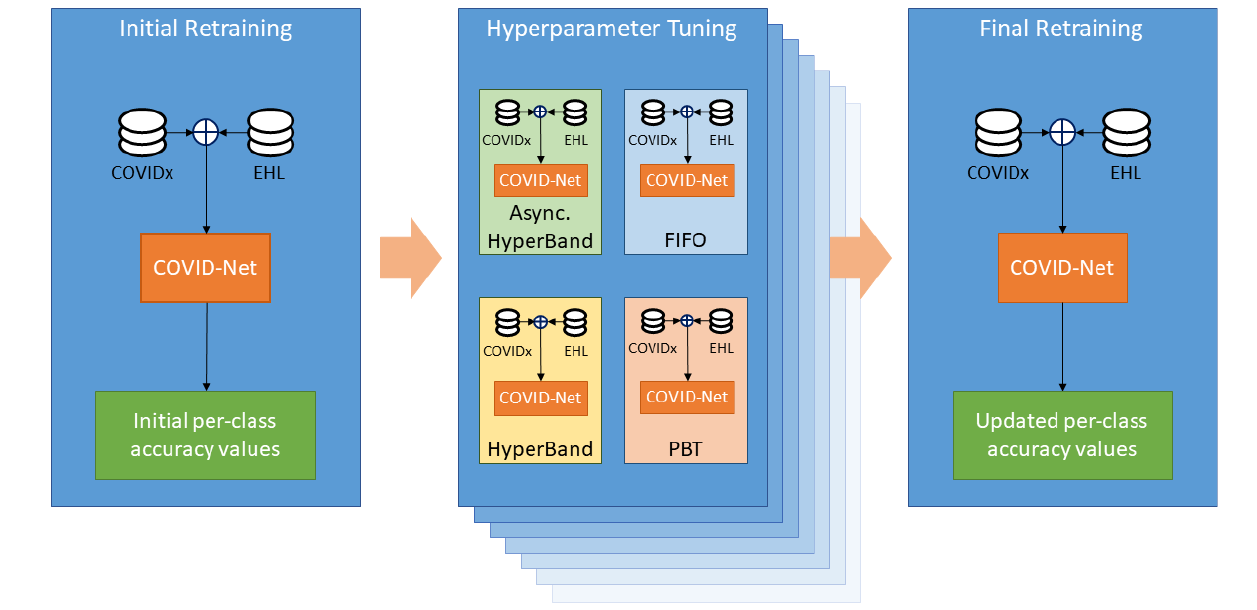
Figure 1. Block diagram representing the experimental process within the data analysis and machine learning platform. The different schedulers are represented as boxes within the hyperparameter tuning step. Due to the large amount of computations that it needs to perform, the hyperparameter tuning step requires significantly more resources than the remaining